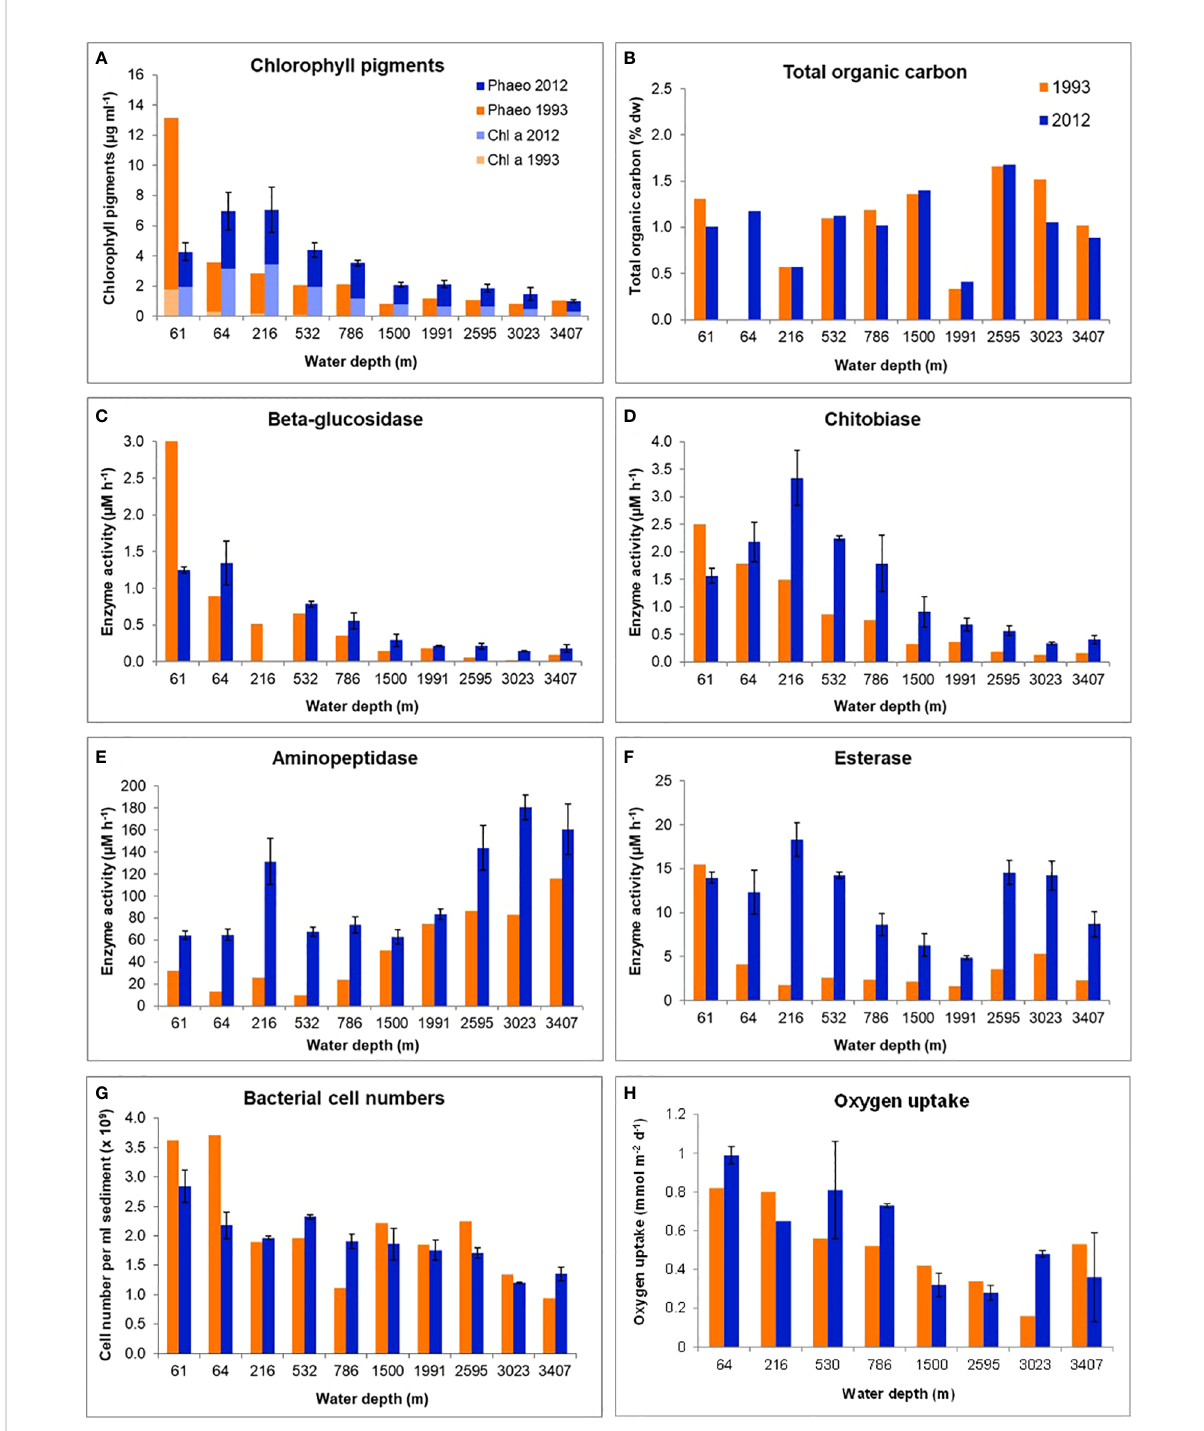
FIGURE 5 Biogeochemical parameters in surface sediments (0-1 cm) with increasing water depth along the Laptev Sea continental slope in September 1993 and August/September 2012. Water depths are averages of stations sampled in 1993 and 2012 (see also Table 1). (A) Chlorophyll pigment concentrations, (B) Total organic carbon concentrations, (C – F) Extracellular enzymatic activities of beta-glucosidase, chitobiase, aminopeptidase and esterase, (G) Bacterial cell numbers (Numbers correspond to ~ 20 - 80 µg C cm -3 ), (H) Benthic oxygen uptake. The values correspond to a carbon remineralization rates of 1.5-7.6 mg C m -2 d -1 in 1993 and 2.3-9.2 mg C m -2 d -1 in 2012. (1993: 0.5-2.8 g C m -2 yr -1 ; 2012: 0.8-3.4 g C m -2 yr -1